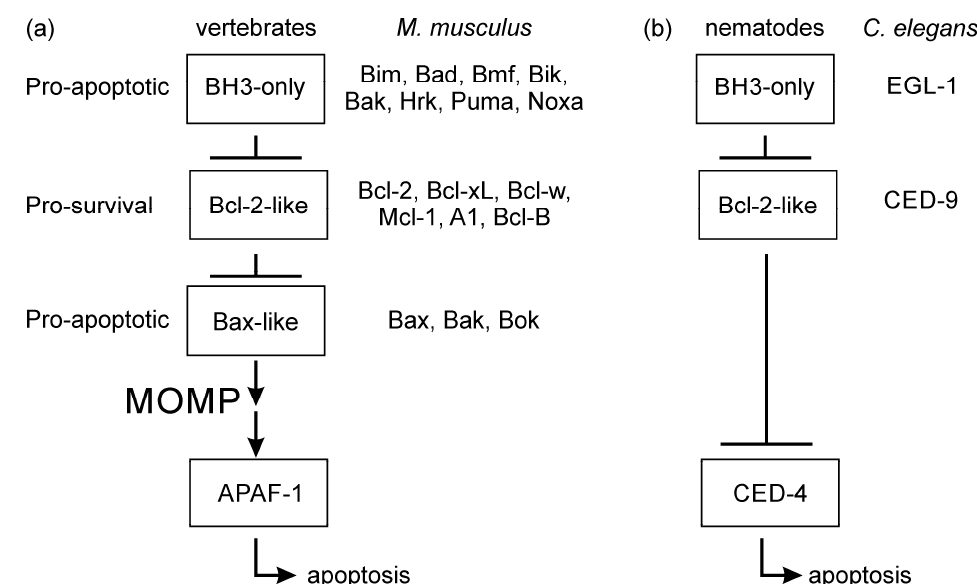
Figure 1. Simplified apoptosis schemes for vertebrates and nematodes. ( a ) The 17 members of the Bcl-2 family of M. musculus are indicated in the three classes. ( b ) The Ecdysozoan C. elegans apoptosis scheme is much simplified compared to that in mammals bearing a single Bcl-2 protein CED-9 and BH3-only protein EGl-1. The result of either signalling pathway is the activation of caspases that dismantle the cell.